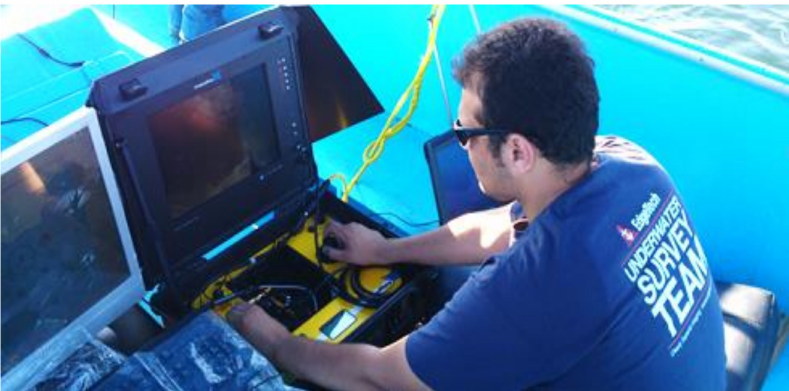
Figure 3. The researcher during the piloting of the ROV camera onboard the research vessel.